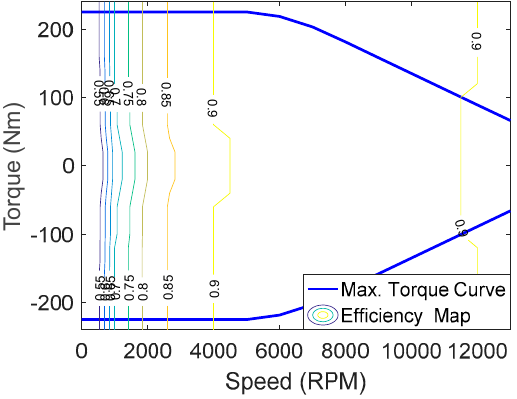
Figure 3. E ffi ciency map of the traction Figure 3. Efficiency map of the traction motor. Figure 3. Efficiency map of the traction motor.